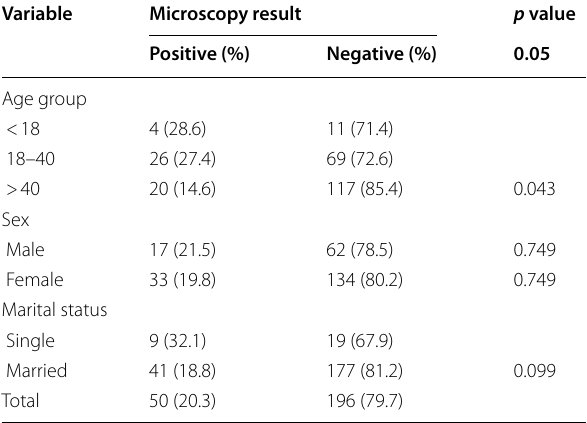
Table 2 Prevalence of lymphatic filariasis in Imobi, Ijebu East Local Government Area in relation to age group, sex and marital